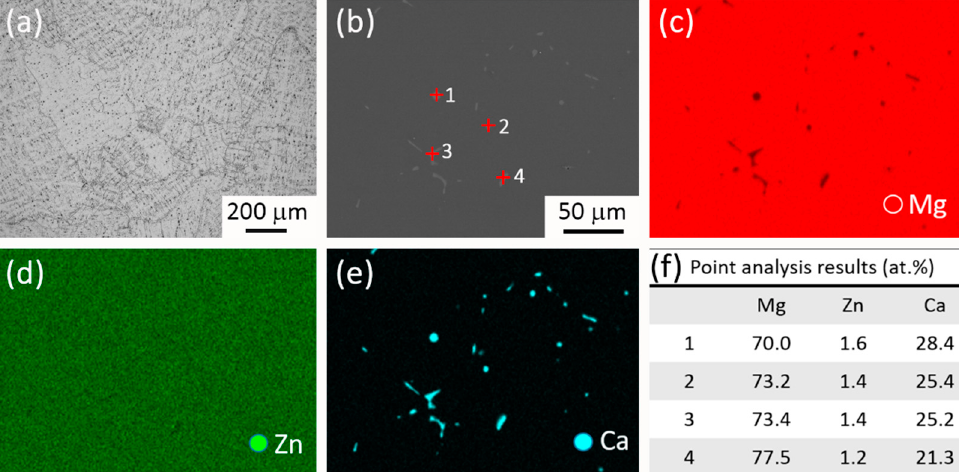
Figure 1. ( a , b ) Optical micrographs of the as-cast ZX10 alloy and ( c – e ) EDS analysis of as-cast ZX10 alloy: ( c ) SEM image, corresponding elemental maps of Ca ( d ) and Zn ( e ), and ( f ) point analysis results of second phase precipitates identified (with red crosses) in ( c ).